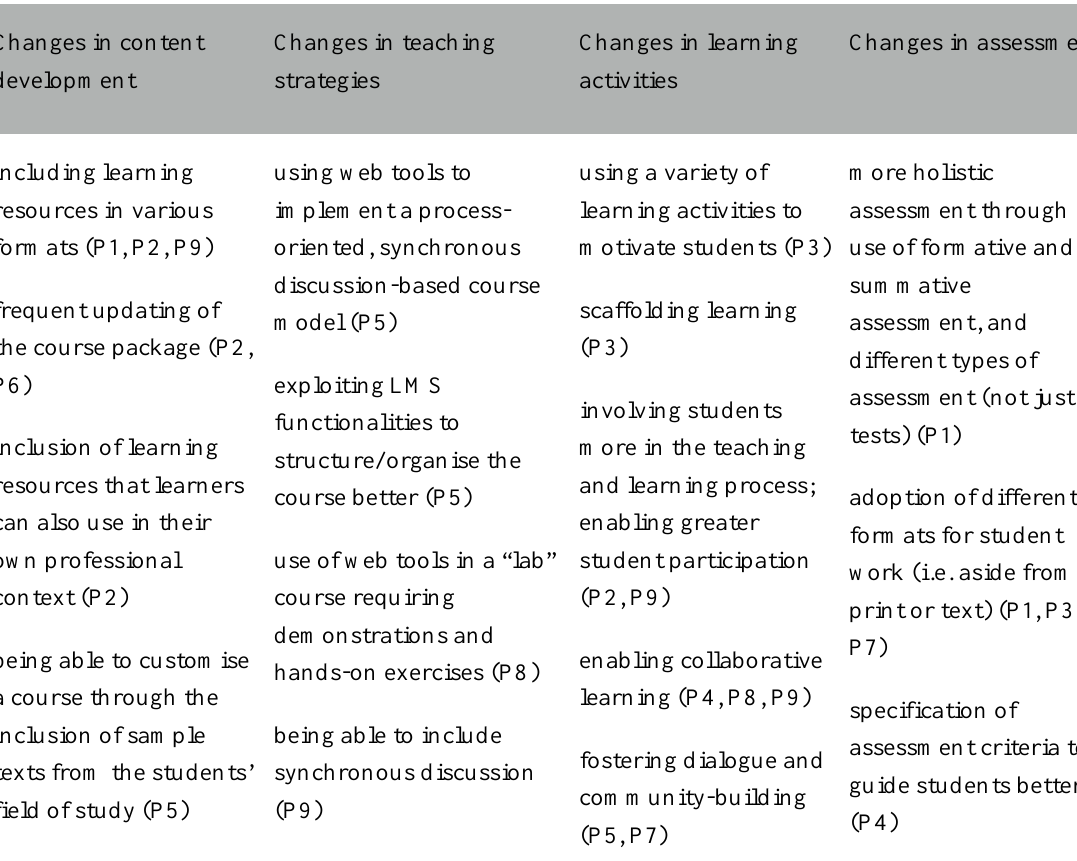
Summary of Changes in Participants’ Course Design